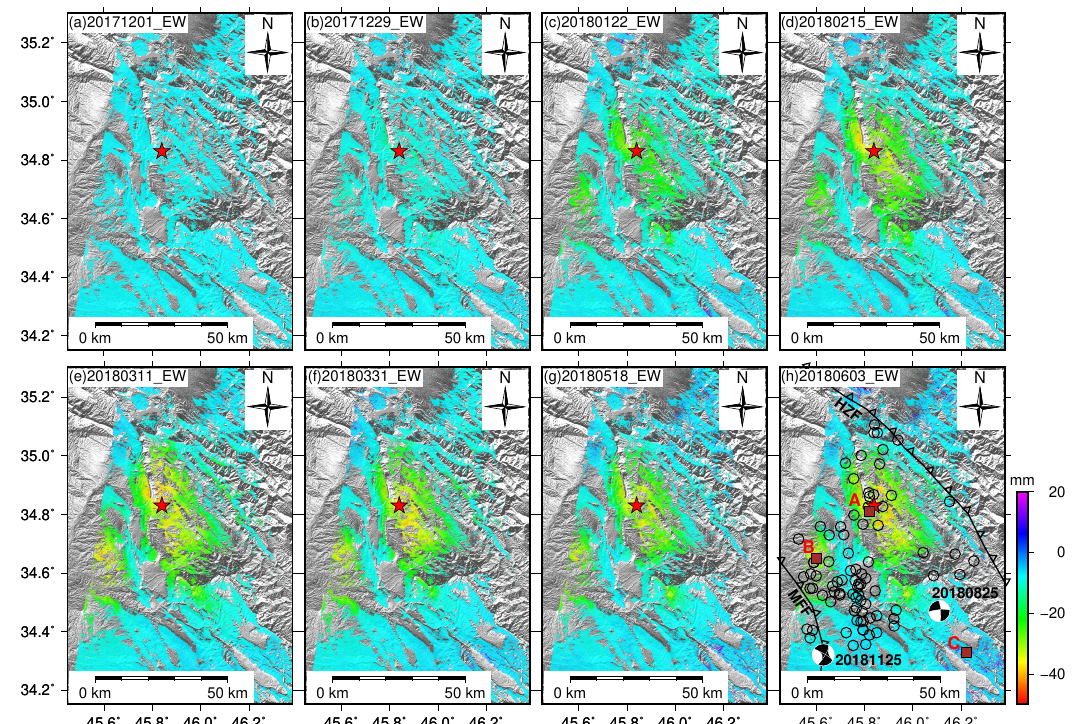
Figure 10. Time series of the cumulative horizontal east–west deformation from 19 November 2017 to 3 June 2018 (positive and negative values represent eastward and westward movements, respectively). The black circles indicate aftershocks (M W > 3.0) up to 220 days after the mainshock. The brown squares represent the selected feature patch. The two beach balls represent earthquakes > M W 5.0. Red stars represent the